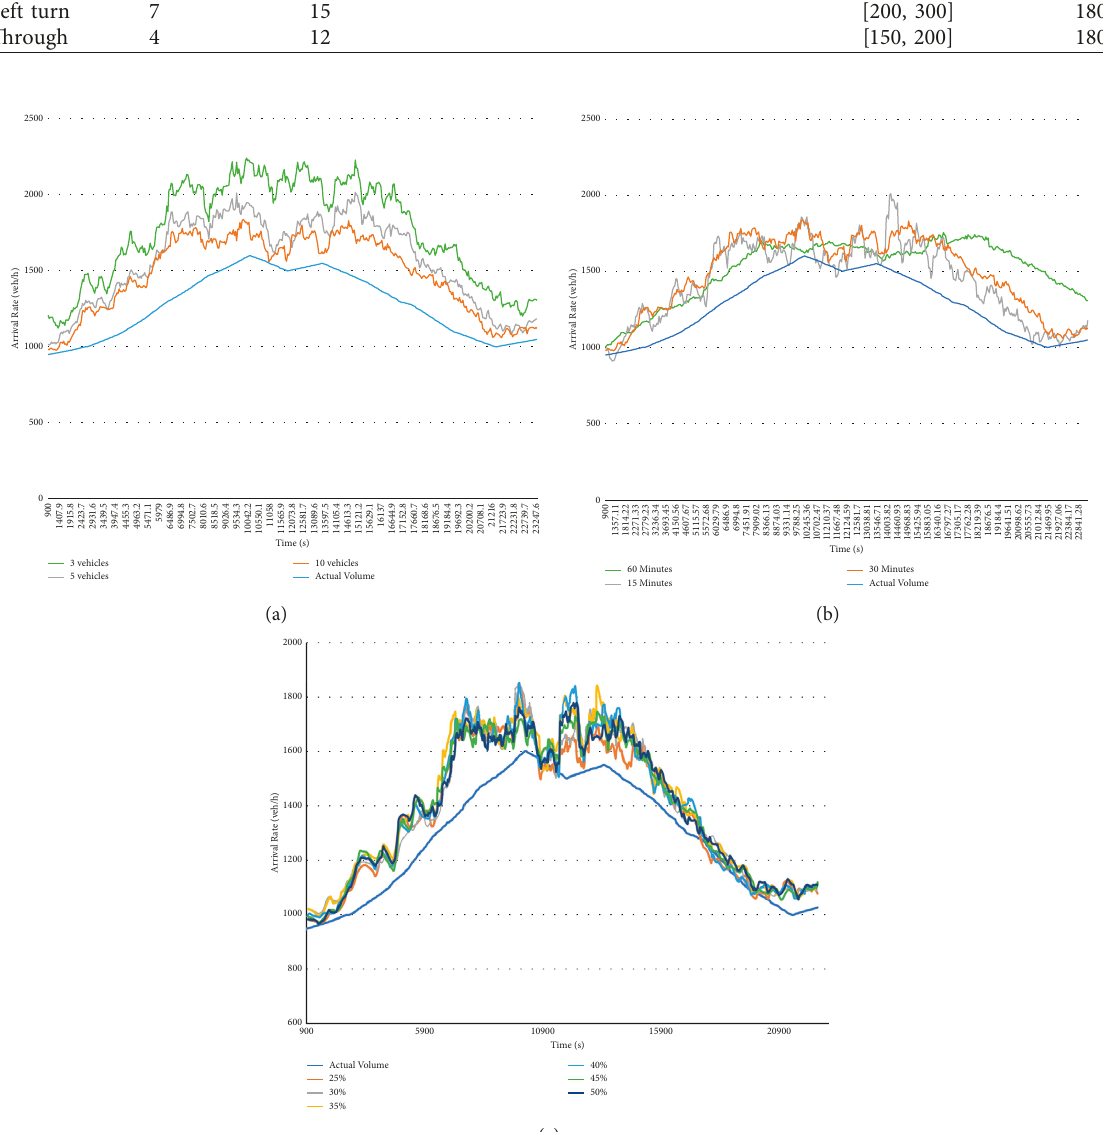
Figure 6: Arrival rate estimation results (a) Arrival rate estimation results in different sampling lengths (b) Arrival rate estimation results in different sampling times (c) Arrival rate estimation results in different CV penetration rates.